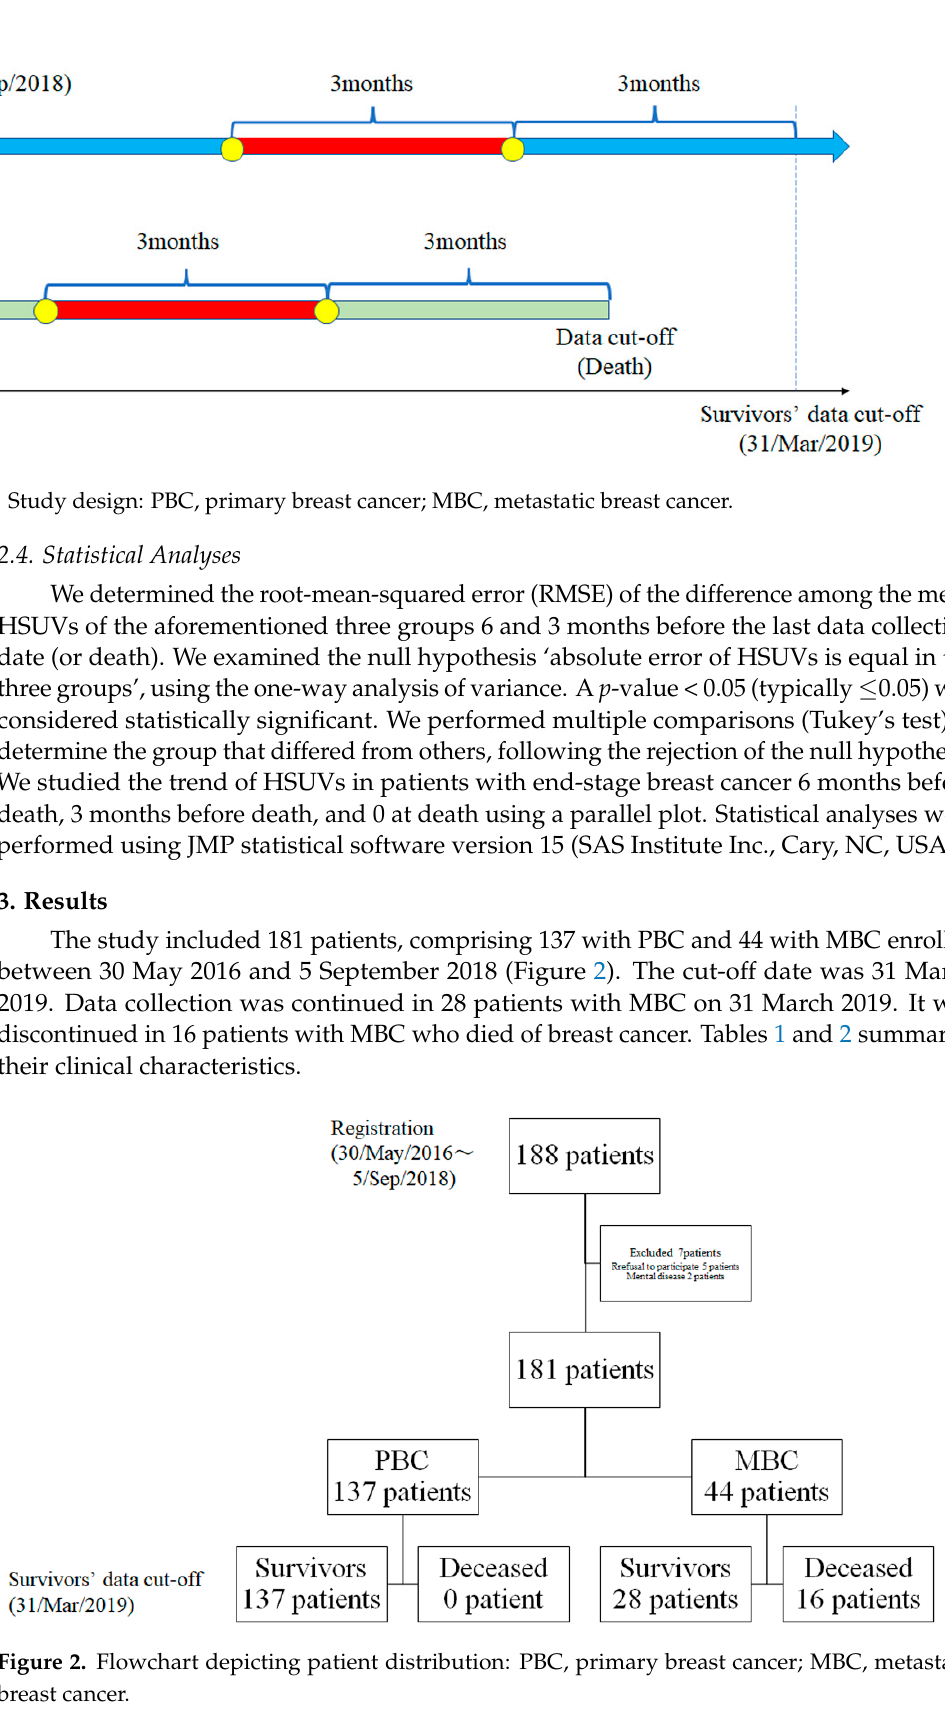
Figure 2. Flowchart depicting patient distribution: PBC, primary breast cancer; MBC, metastatic breast cancer .